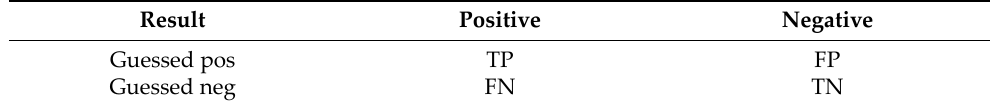
Table 3. Evaluation indicators.